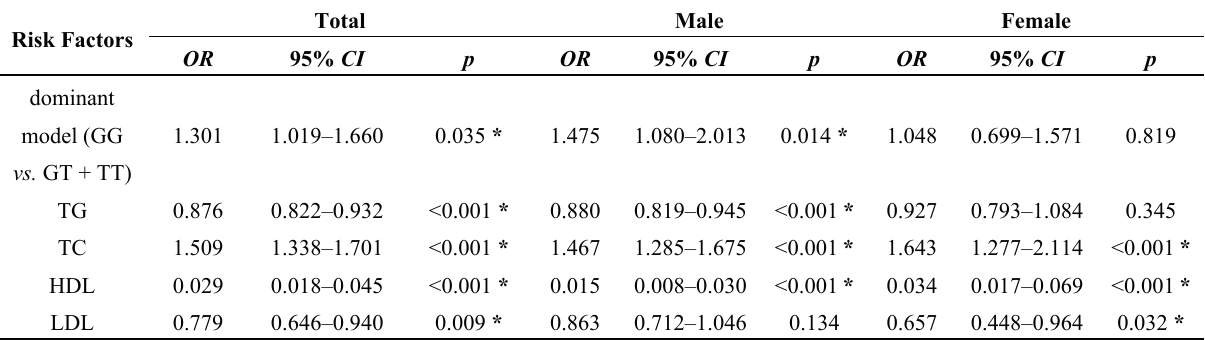
Table 4. Multiple logistic regression analysis for T2DM patients and control subjects (rs12255372).